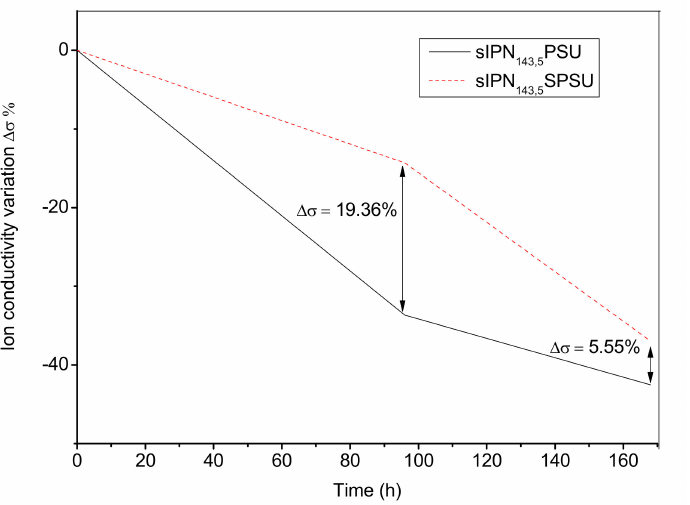
Figure 7. Ionic conductivity variation of the membranes sIPN 143,5 -PSU and sIPN 143,5 -SPSU after 96 and 168 h in a 1 M KOH solution at room temperature.